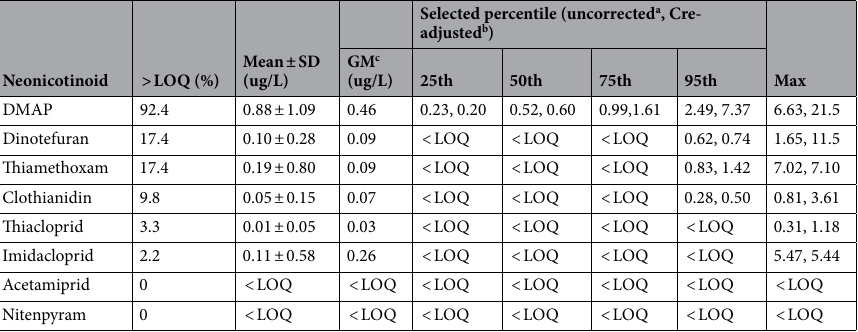
Table 8. Concentration and detection rate more than LOQ of urinary neonicotinoids and DMAP. GM geometric mean; a Unit of uncorrected concentration is ug/L; b unit of creatinine-adjusted concentration is μg/g